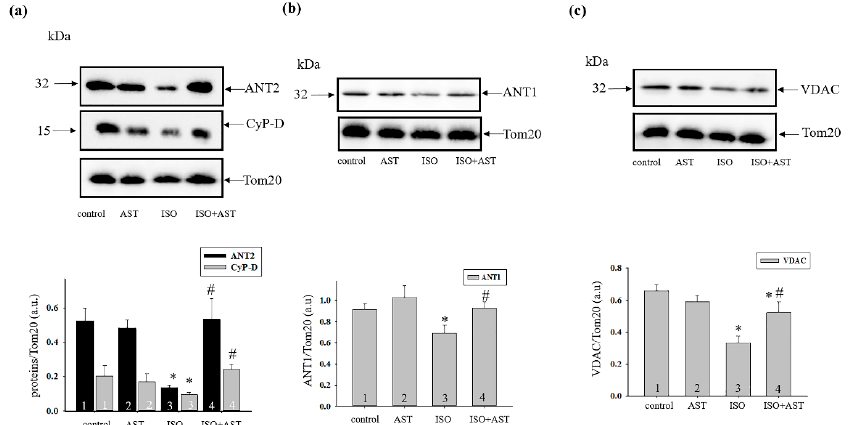
Figure 6. The effects of AST and ISO on the content of the mitochondrial proteins, such as adenine nucleotide translocase (ANT1 and ANT2), cyclophilin D (CyP-D), and voltage-dependent anion channel (VDAC), in RBM isolated from rats from every group. ( a – c ) (Upper part)—Western blots stained with corresponding antibodies. ( a – c ) (lower parts)—quantitative characteristic reflecting the ratio of proteins to Tom20 (loading control). The data are presented as the mean ± SDs of five independent experiments. * p < 0.05 indicates a significant difference in the protein level relative to the control (group 1). # p < 0.05 a significant difference compared to ISO alone (group 3).